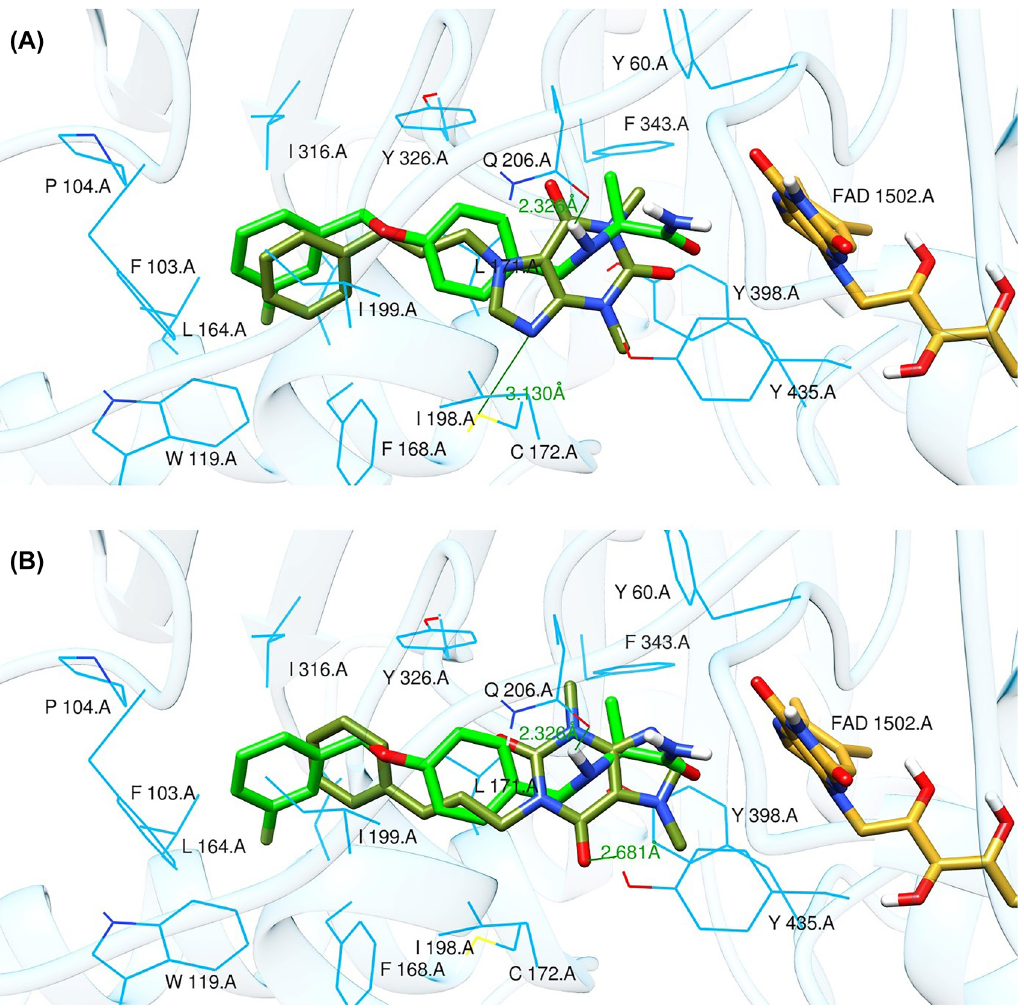
Figure 8: Binding poses of selected lead compounds: CNP0202316 (A) and CNP0365210 (B) (shown in olive green color) with MAO-B and superposed to safinamide (shown in green